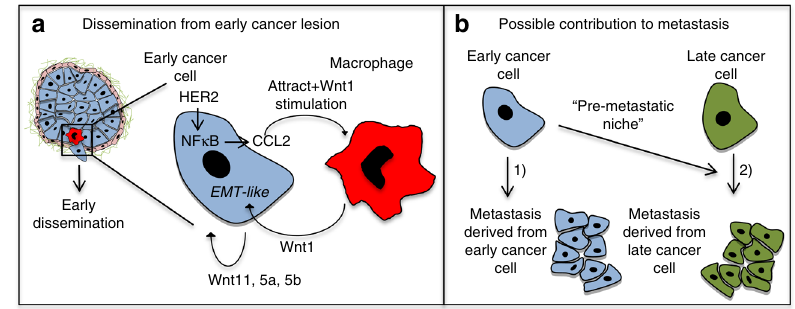
Fig. 8 Models summarizing fi ndings and potential scenarios for early DCC role in metastasis development. a Scheme of macrophage-regulated early dissemination from pre-invasive lesions where CCR2 + /CD206 hi /F4/80 hi /Tie2 hi macrophages are attracted into early lesions by HER2-mediated and NF- κ B-mediated upregulation of CCL2. Our models support that intra-epithelial macrophages in turn secrete Wnt-1 in response to CCL2 production by cancer cells and also other immune cells and thereby further cement an EMT-like response that is also stimulated by autocrine/paracrine production of other Wnt ligands 8, 9 to drive early dissemination. b Early DCCs contribute to metastasis formation, either as a slow cycling seeds of metastasis (scenario 1) or by interacting with the microenvironment and/or later arriving DCCs to create a “ pre-metastatic niche ” that is eDCC-orchestrated and more permissive for the growth of late or early and late cancer cells